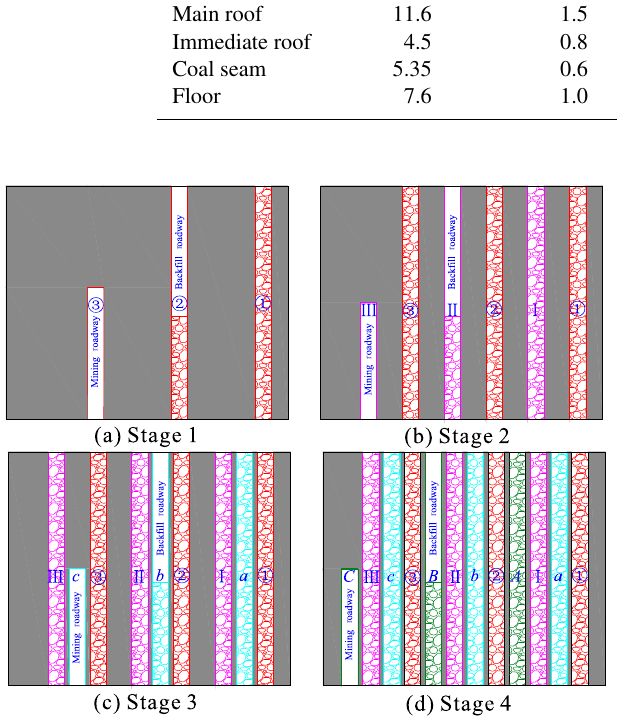
Figure 9. Simulation of driving on multiple